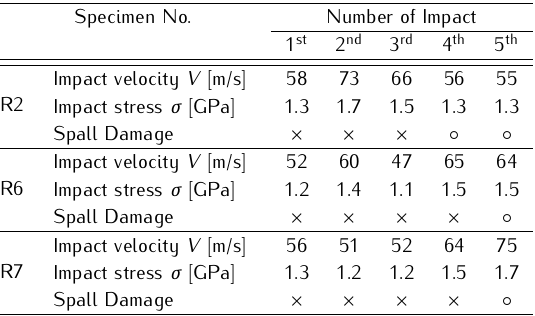
Figure 2. The clarification of our acoustic microscopy provided in a graphical form. To suppress the ringing of the reflected wave, an external attenuator was added to the measuring circuit, while the additional oscilloscope was used to detect the acoustic wave reflected from the damaged